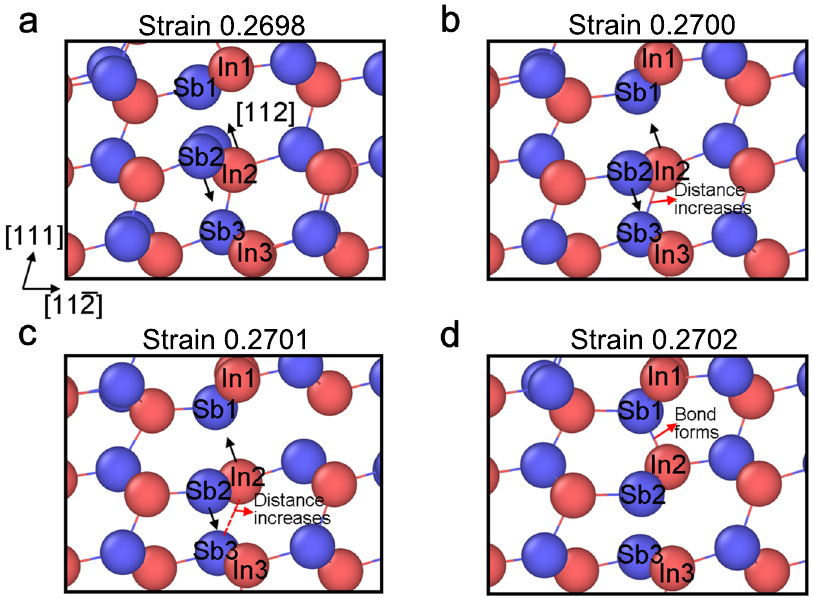
Fig. 5 Local atomic con fi guration extracted from Fig. 2c during twin nucleation. a – d Atomic structure at strain a 0.2698, b 0.2700, c 0.2701, and d 0.2702. The red atoms are In and the blue atoms are Sb. From a to d , In2 and Sb2 keep moving relatively along the ð 111 Þ½ 112 (cid:2) direction. Distance between In2 and Sb3 keeps increasing in b and c ; new bond between In2 and Sb1 forms in d